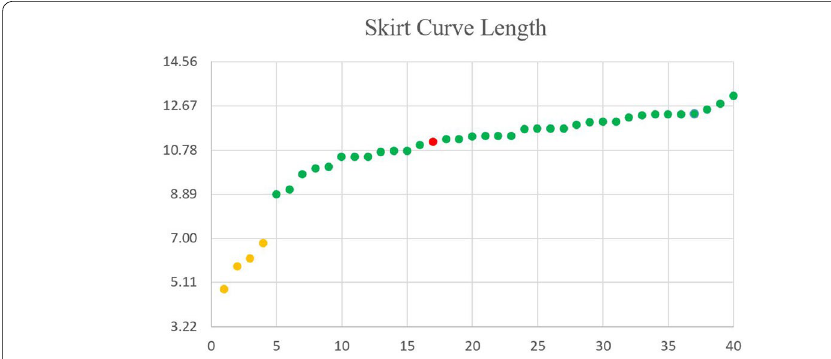
Fig. 6 Skirt Curve Length dimension dot graph. The red dot denotes the fit model. The two groups are clearly split by nearly a two-inch